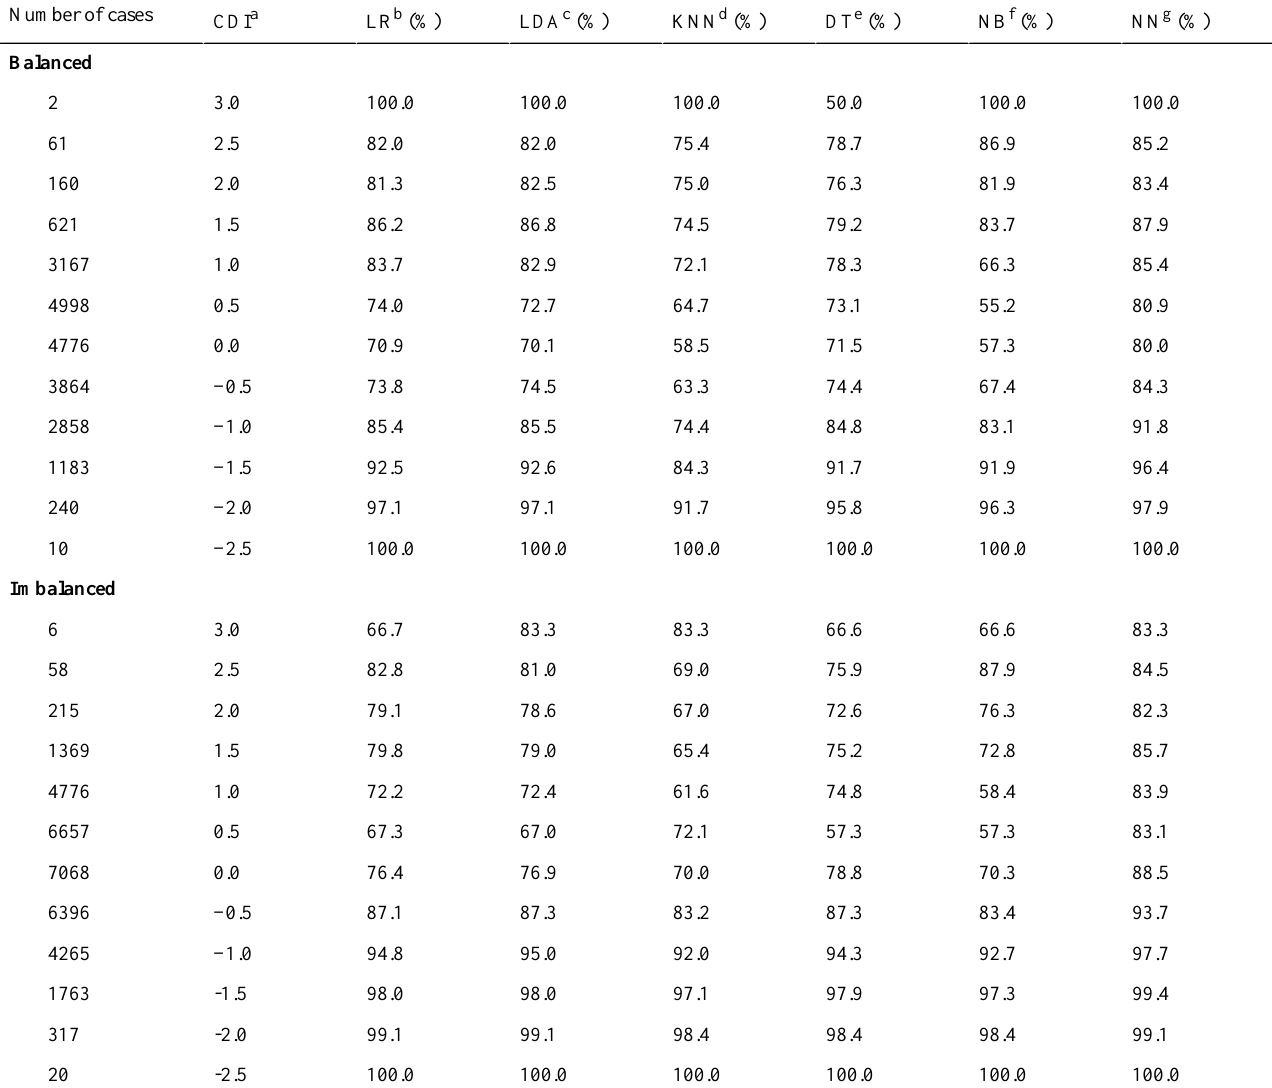
Table 9. Item response theory–based electronic intensive care unit mortality prediction accuracy stratified by classification difficulty